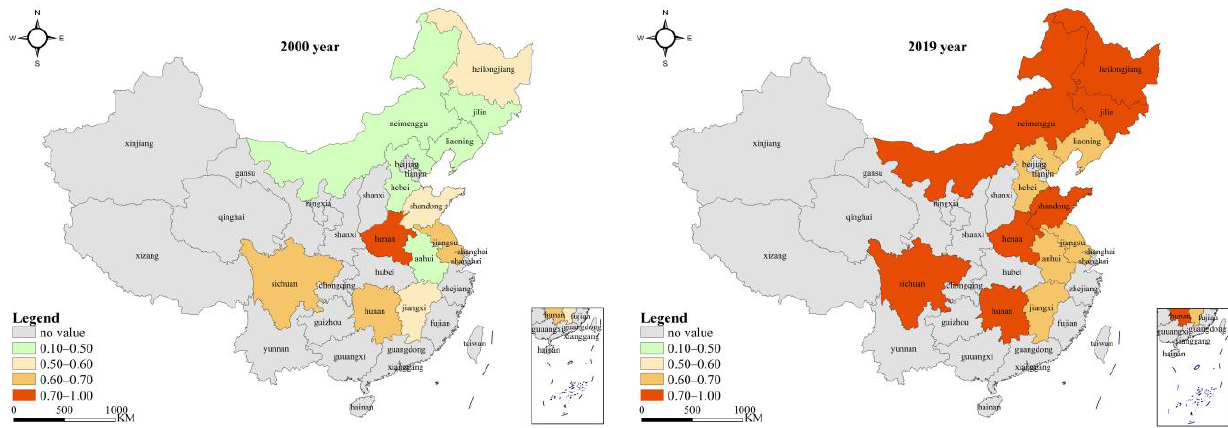
Figure 2. Comparison of the comprehensive technical efficiency of grain production resource allocation in the major grain-producing areas in China in 2000 and 2019 after adjustment.